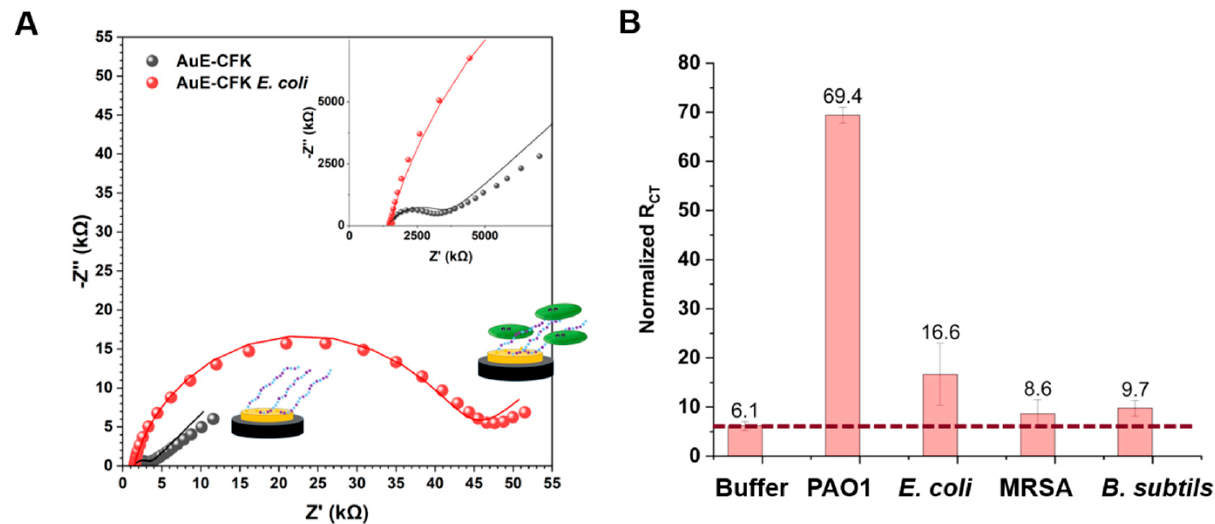
Figure 5. Impedimetric response of AuE-CFK to exposure to bacteria. ( A ) A Nyquist plot of AuE- CFK before (black) and after (red) a 40 min incubation with E. coli . Raw data are presented as circles and as lines when fit to a Randles circuit. ( B ) Normalized R CT values of AuE-CFK after exposure to bacteria. Results are Avg + SD of 3 different electrodes with 3 exposure repetitions.